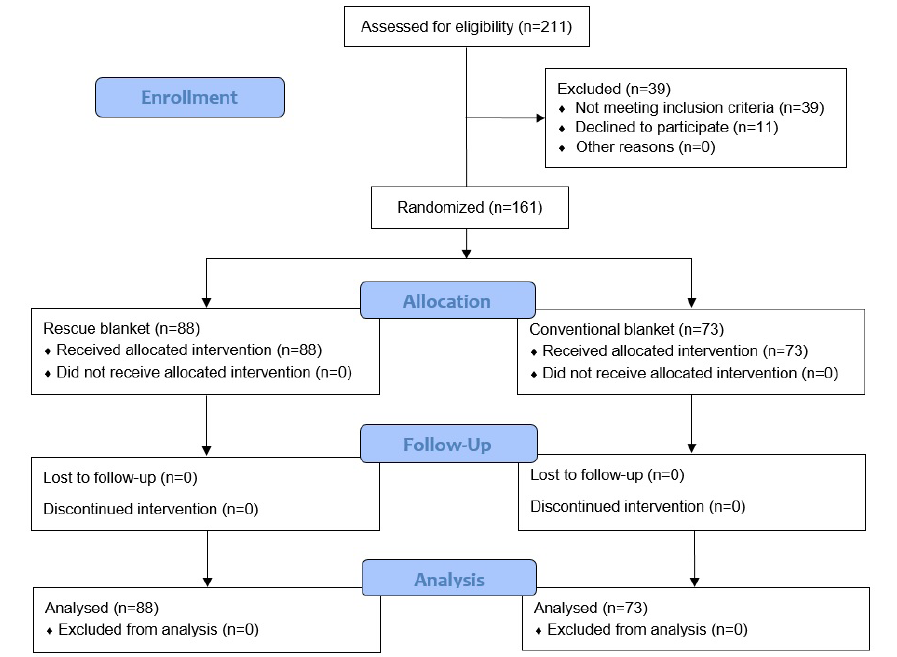
Figure 1. CONSORT flowchart of enrolled patients.